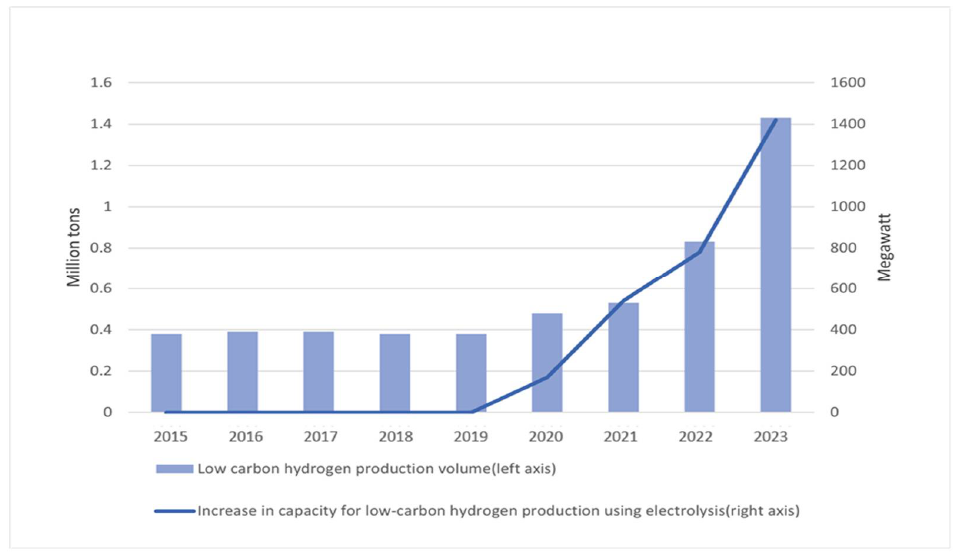
Figure 1. Status and prospects of global hydrogen production. Source: IEA, June 2020 .